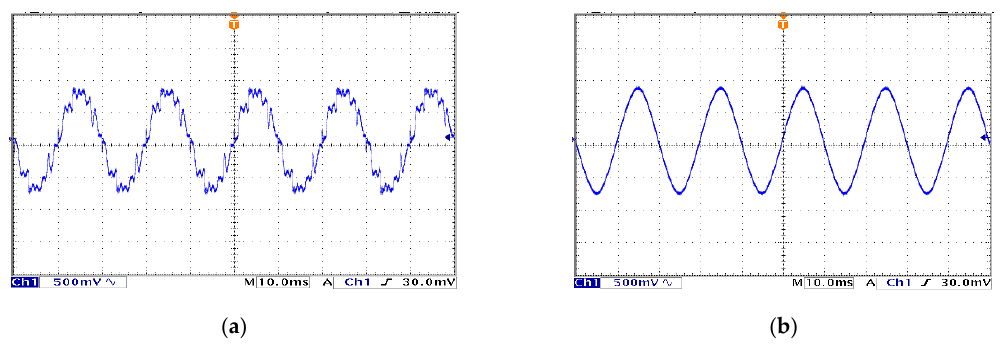
Figure 17. Current waveform in the PV micro-grid. ( a ) Load side current waveform. ( b ) PCC side current compensated waveform.